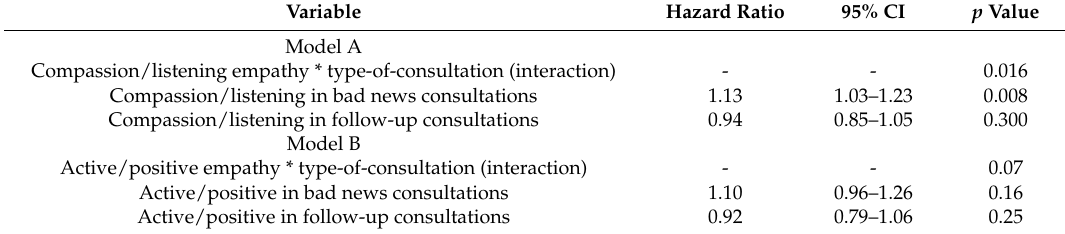
Table 4. Adjusted Cox Proportional Hazard Models for overall survival with specific types of